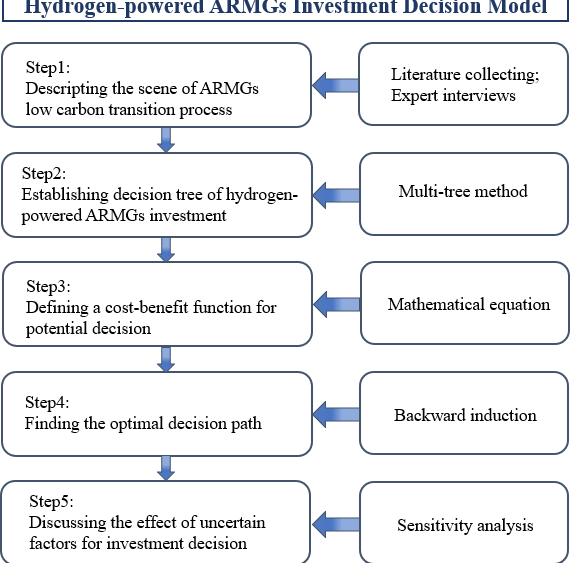
Figure 1. The specific process of the five steps for the hydrogen-powered ARMGs investment decision model.